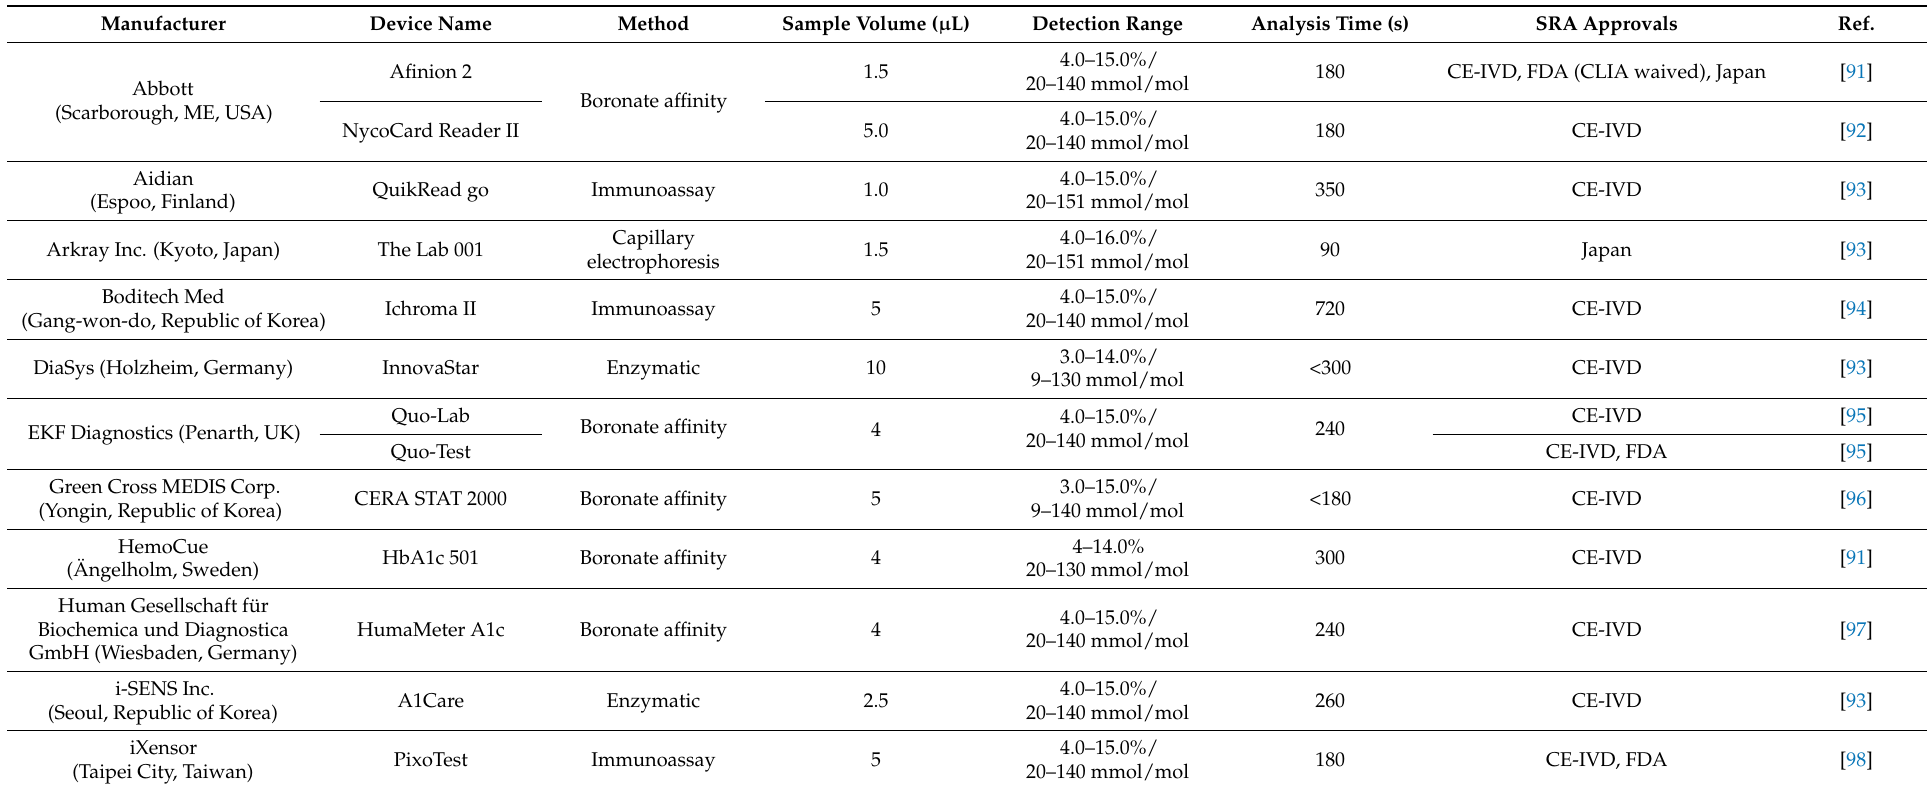
Table 4. List of various commercial PoC analyzers for evaluating